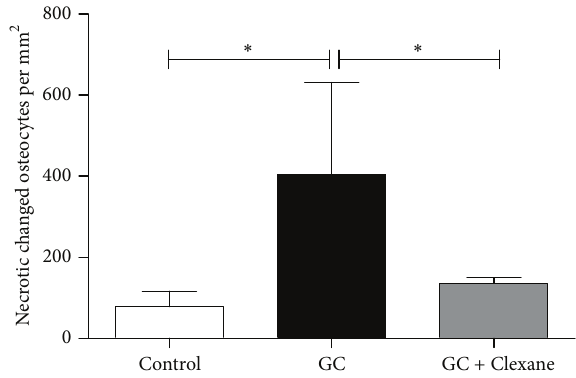
Figure 4: Enoxaparin treatment decreases glucocorticoid-induced necrotic changes of osteocytes. The application of enoxaparin with methylprednisolone reduces significantly the amount necrotic changed osteocytes per mm 2 in the femoral head of rabbits due to methylprednisolone treatment to control levels. The graph repre- sents the mean score with SEM of empty lacunae. Statistical analysis was performed with one-way ANOVA followed by Bonferroni’s multiple comparison test (control versus GC, control versus GC + Clexane, and GC versus GC + Clexane). ( ∗ 𝑃 < 0.05 ).